Question: Sum up the contents of this chart in one sentence.
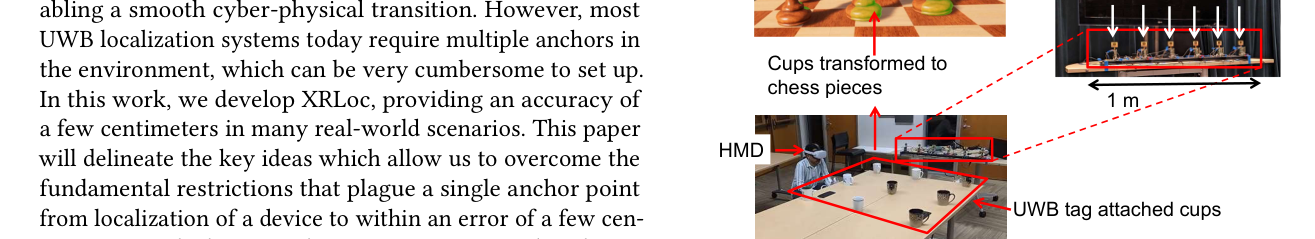
Answer: XRLoc enables users to play a life-size chess game with everyday objects. XRLoc localizes mugs retrofitted with off-the-shelf UWB tags from a sin- gle vantage point with a few cm of location accuracy, which are then translated to chess pieces in the virtual world.